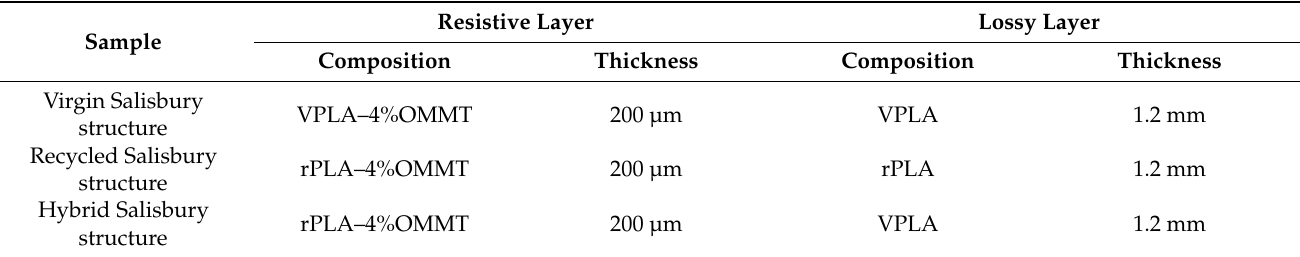
Table 3. Summary Salisbury screens measured under